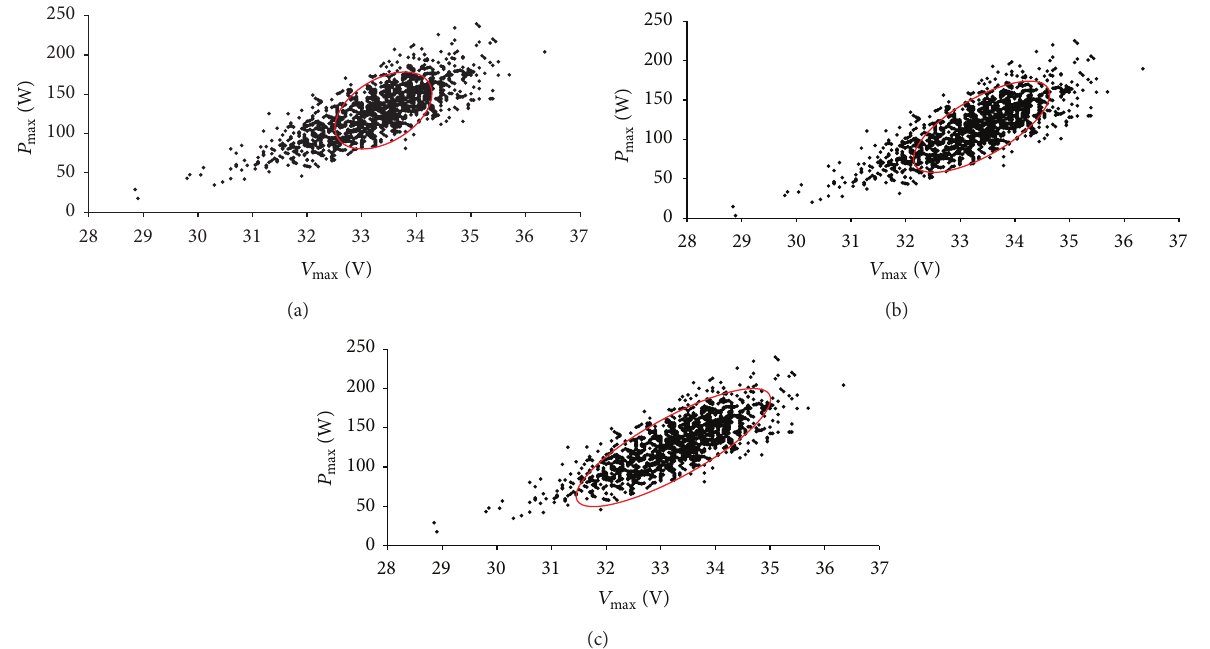
,𝑃 ) for the first set of simulated environment mpp mpp